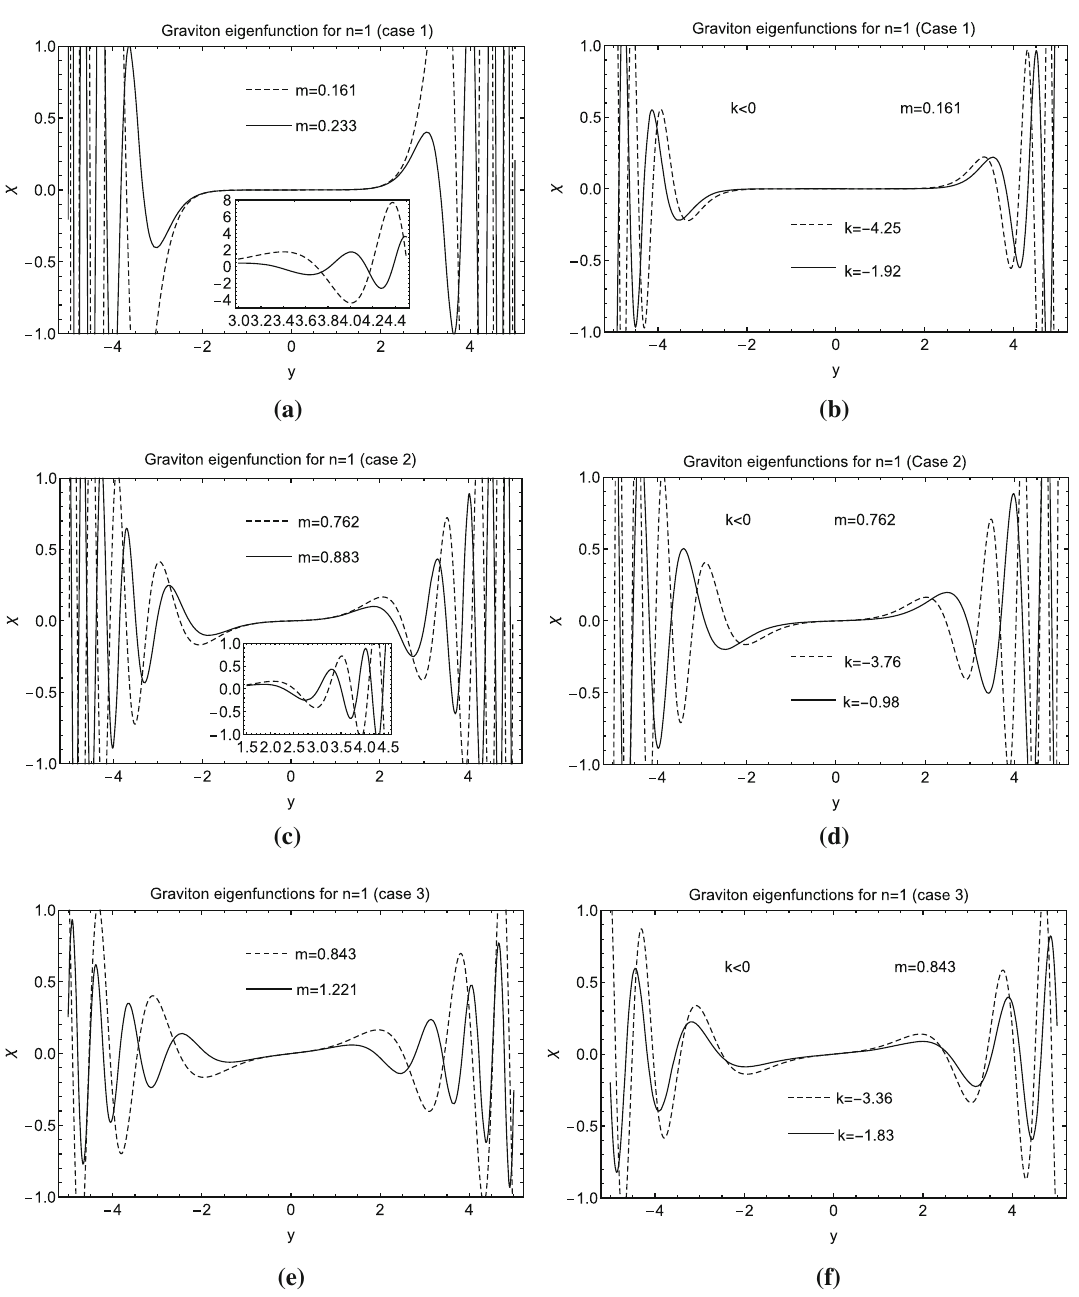
Fig. 7 Massive modes for n = 1 and k 0 = α = β = 1. a , b Periodical superpotential. c , d Polynomial superpotential. e , f Fractional